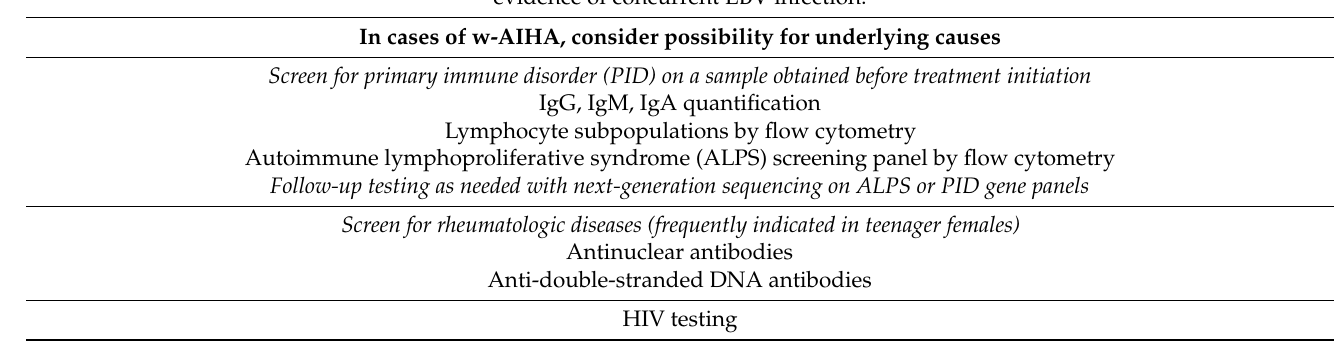
thrombocytopenia and/or neutropenia, unusual or prolonged reticulocytopenia, lymphadenopathy or organomegaly without evidence of concurrent EBV